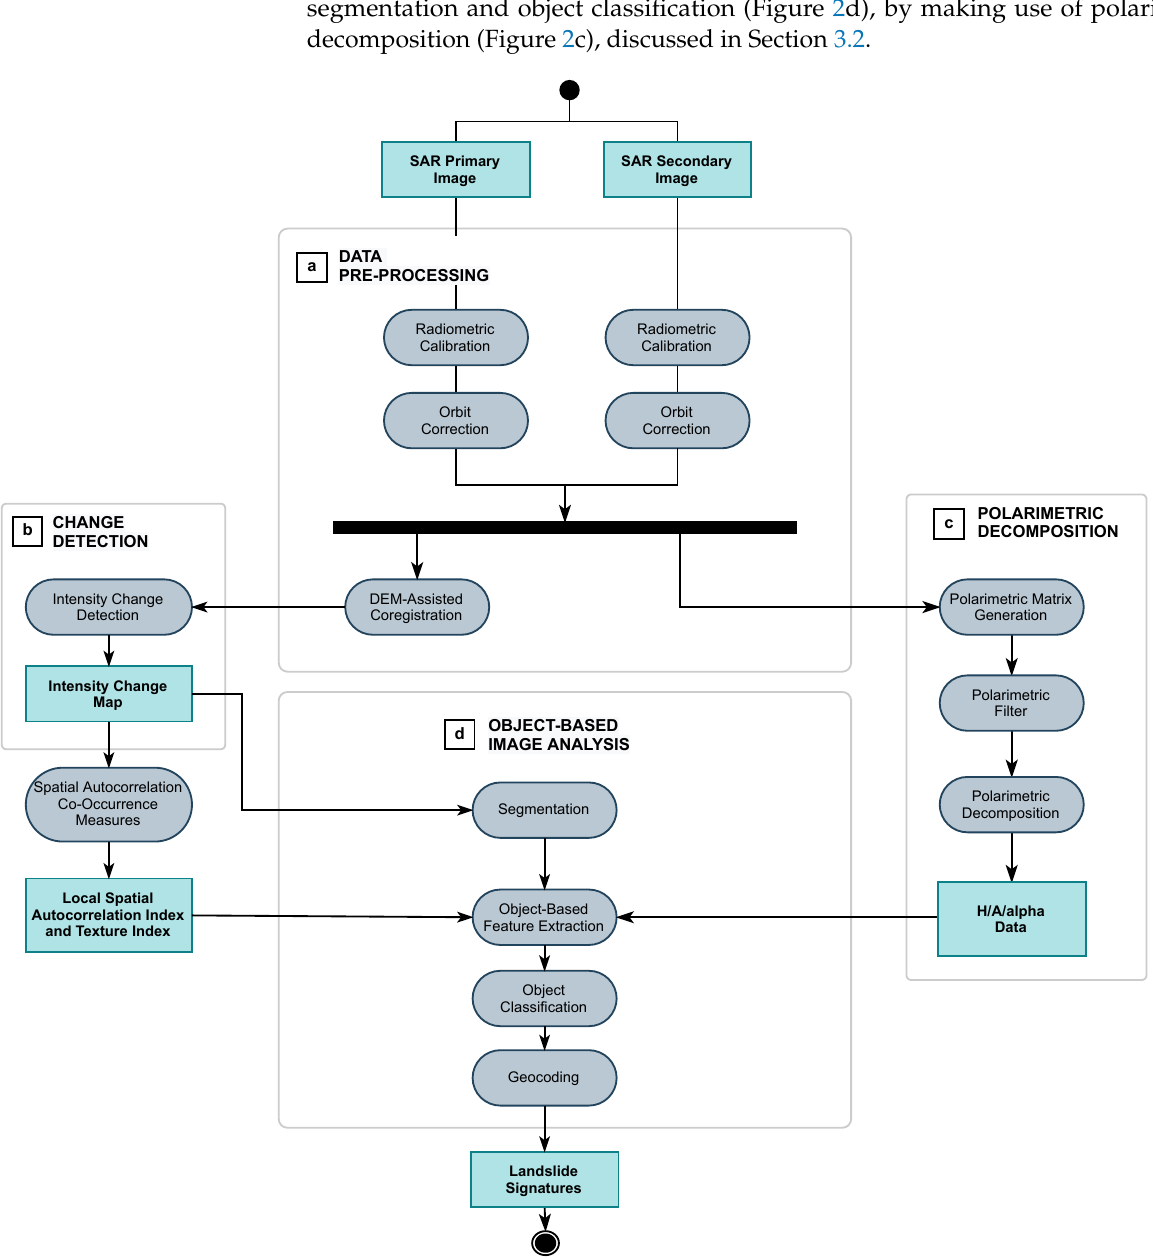
Figure 2. Workflow for detecting land-cover change based on Synthetic Aperture Radar (SAR) intensity change for the identification of